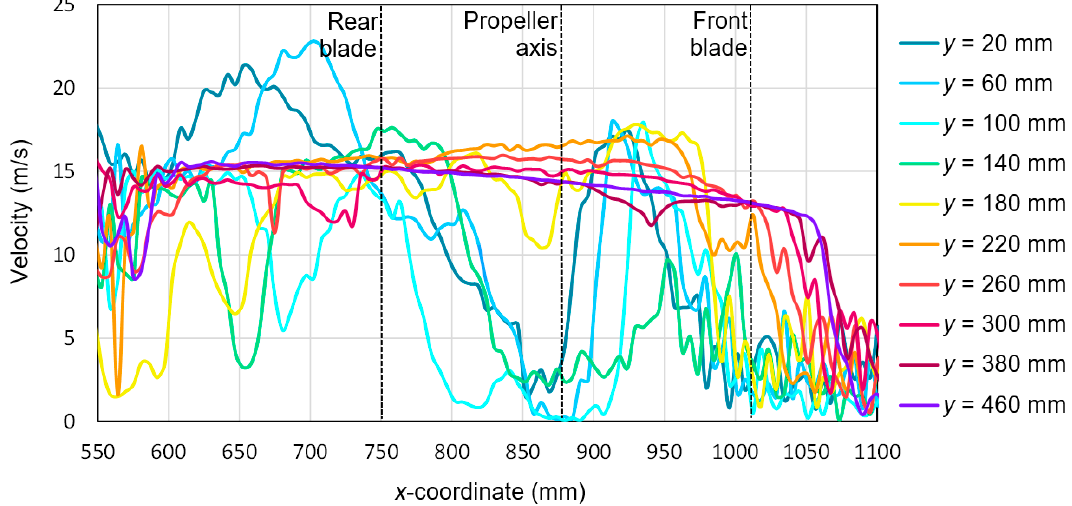
Figure 17. Resultant airflow velocities around the research object for the following configuration: angle of attack α = 0° and airflow in the wind tunnel v wt = 12.5 m/s.